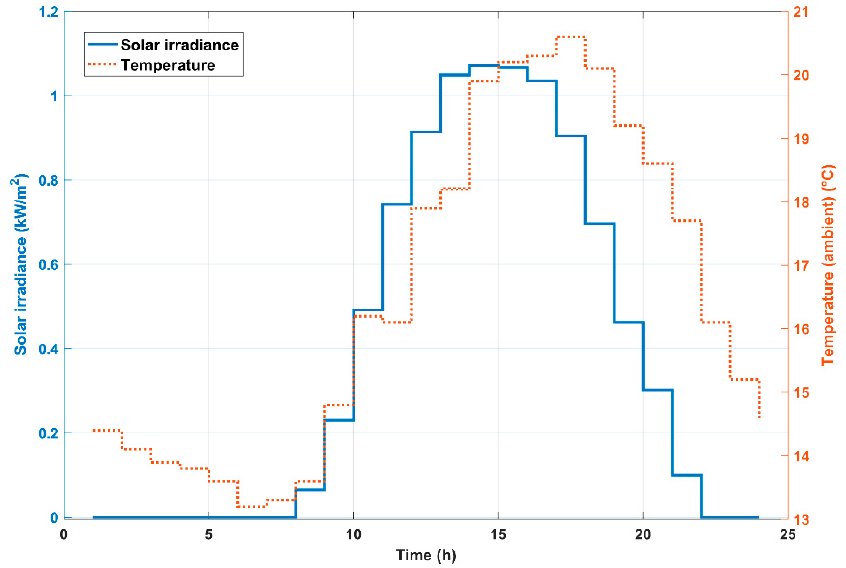
Figure 3. Solar radiation flux (irradiance) and ambient temperature data for the case